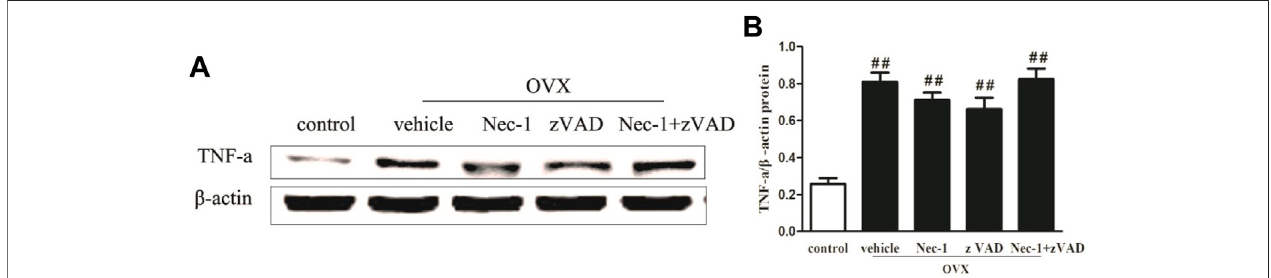
FIGURE 5 | TNF- α expression in OVX rats. (A) Western blot of TNF- α protein expression and (B) its quantitative analysis in the osteocytes of sham-operated and OVXratstreatedwithvehicle,Nec-1,orzVAD(n (cid:1) 6).## p < 0.01comparedwiththecontrolgroup,* p < 0.05comparedwiththevehiclegroup,** p < 0.01comparedwith the vehicle group.